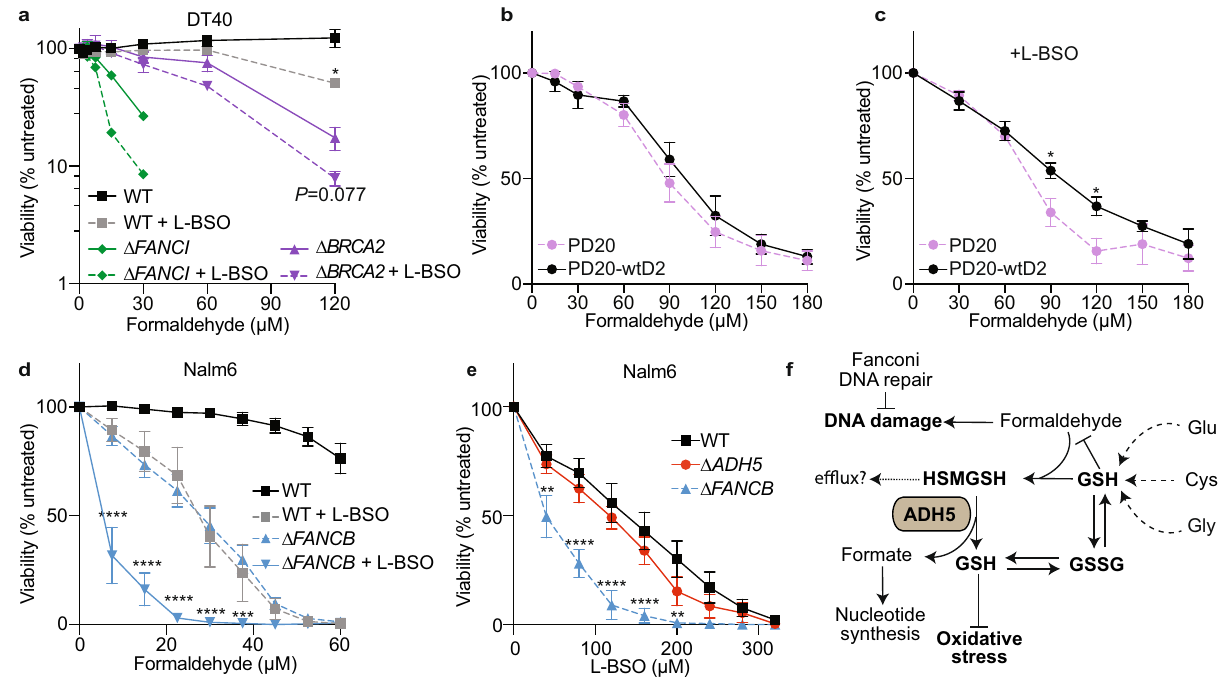
Fig. 7 ADH5 and GSH synthesis determine formaldehyde tolerance in DNA repair-de fi cient cells. a Viability assay for Wild type (WT), Δ BRCA2 and Δ FANCI DT40 cells exposed to formaldehyde (FA) and 50 μ mol L − 1 L-buthionine-sulfoximine (L-BSO) for 3 days ( n = 3, mean ± SEM, for WT and Δ BRCA2 , two-tailed unpaired t-test, * P = 0.0264 (WT), n = 2 for Δ FANCI ). For Δ FANCI cells at 60 and 120 µ mol L − 1 FA, the viability values after subtraction of the blank were cero and were excluded to perform the logarithmic plot. µ M refers to µ mol L − 1 . b Resazurin-based viability assay for PD20 ( FANCD2 − / − ) cells and the complemented version expressing a WT copy of FANCD2 (PD20-wtD2) exposed to increasing concentrations of FA for three days ( n = 6 for PD20 and n = 5 for PD20-wtD2, mean ± SEM). c Viability assay for PD20 and PD20-wtD2 cells exposed to FA in the presence of 500 μ mol L − 1 L-BSO for three days ( n = 6, mean ± SEM, two-way ANOVA, using a Bonferroni test for multiple comparison, * P = 0.0417 (90 µ mol L − 1 FA), * P = 0.0226 (120 µ mol L − 1 FA). d Viability assay for Nalm6 cells exposed to FA and 50 μ mol L − 1 L-BSO ( n = 5, mean ± SEM, two-way ANOVA for multiple comparison using a Bonferroni test between Δ FANCB and Δ FANCB + L-BSO 50 μ mol L − 1 , **** P < 0.0001, *** P = 0.0007). e Viability assay for Nam6 cells exposed to L-BSO ( n = 6, mean ± SEM, two-way ANOVA for multiple comparison using a Bonferroni test between WT and Δ FANCB cells, ** P = 0.0056 (40 µ mol L − 1 ), **** P < 0.0001, ** P = 0.0030 (200 µ mol L − 1 )). f Model for FA metabolism and the crosstalk with GSH metabolism highlighting the formation of HSMGSH products and their metabolization through ADH5. GSH supply by ADH5 limits oxidative stress and sustains the balance between GSH and GSH disul fi de